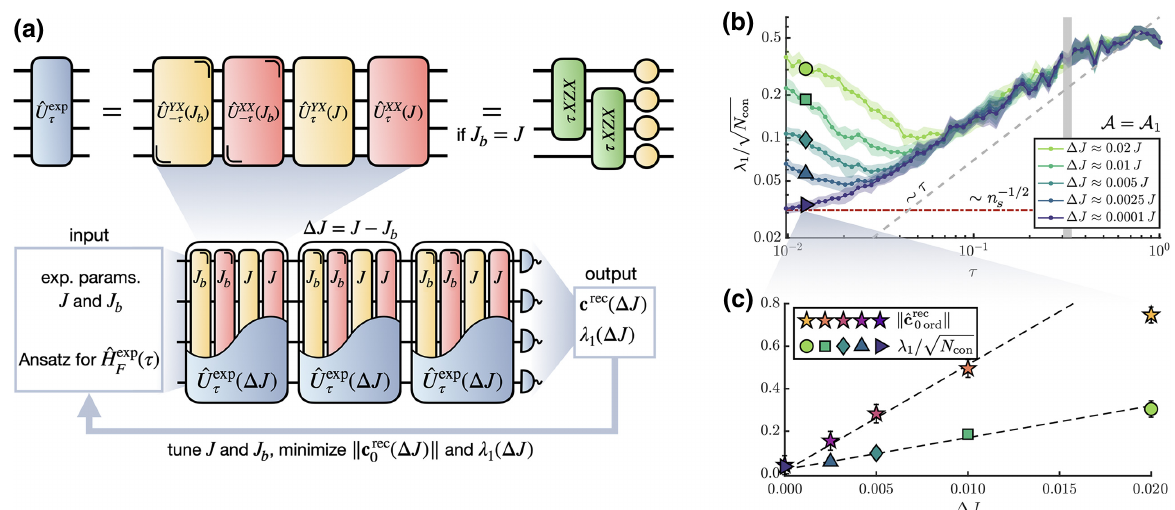
FIG. 6. Generating three-body gates. (a) Schematic view of FHL applied to the design of multibody quantum gates, in the specific √ example of the one-dimensional cluster model studied here, defined in Eq. (20). (b) Log-log plot of λ 1 (τ)/ N con for different values of the difference (cid:11) J between forward and backward time evolutions, for an ansatz A 1 containing only first-order terms. Here, n s = 2000. √ As long as (cid:11) J > 0, λ 1 / N con cannot show scaling for arbitrarily small values of τ (as shown by its increase for smaller τ ). Thus, λ 1 can be used as a cost function to be minimized by tuning the experimental parameters controlling (cid:11) J . As shown in (c), minimizing (cid:8) c (cid:8) , which can be reconstructed by adding A λ √ 1 corresponds to minimizing the norm of the zeroth-order terms rec,0ord. 0 to the ansatz. Once λ 1 / N con falls below the noise threshold in Eq. (16), we conclude that, within our resolution set by n s , (cid:11) J ≈ 0. The results are obtained for a system of N = 10 spins, using 55 initial product states in random bases, each evolved to six different final times up to a total simulation time of 10 /τ . The error bars stem from measurement noise and from different initial state realizations.